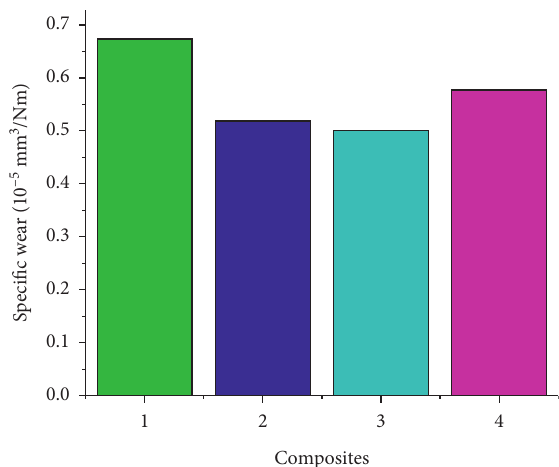
Figure 8: Specific wear rate of the developed composites. (1) Mg alloy; (2) coated Al 2 O 3 ; (3) coated SiC; (4) coated Al 2 O 3 +SiC.